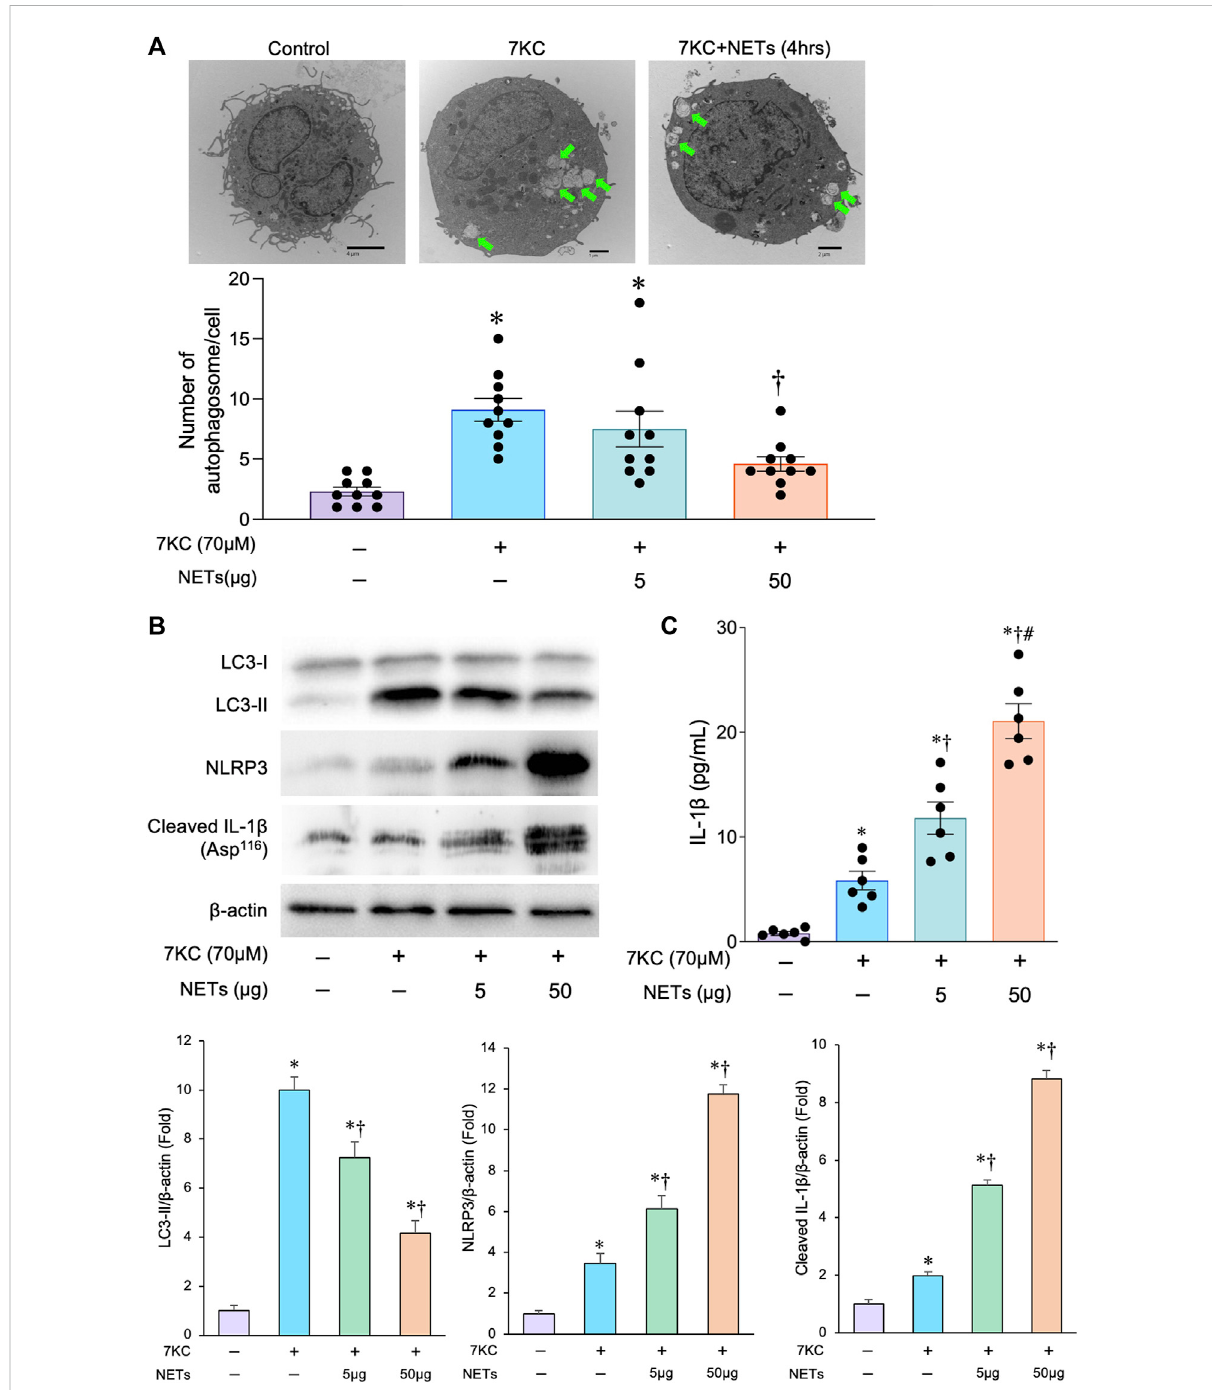
FIGURE 2 Effects of 7KC and NETs on macrophage autophagy in-vitro . (A) Upper panels: Representative transmission electron microscopic images of autophagosomes(arrows)inthemacrophagesdifferentiatedfromTHP-1cellswithandwithouttheadministrationof7KCandorNETs.Lowerpanel: Quantitativeanalysis ofthe number ofautophagosomes with and withouttheadministration of7KC and or NETs. * p < 0.05 vs. control group (Purple bar), † p < 0.05 vs. 7KC-treated group (Blue bar), n = 10 in each group. Data are expressed as dot plots and bars, with lines indicating the mean ± SEM. (B) Upper panel : Representative immunoblot images of LC3, NLRP3, cleaved IL-1 β , and β -actin. Lower panels: Densitometric analysis of immunoblots. * p < 0.05 vs. control group (Purple bar), † p < 0.05 vs. 7KC-treated group (Blue bar), n = 3 in each group. All data are expressed as mean ± SEM. (C) Macrophages differentiated from theTHP-1 cells with and without the administration of the 7KC and or NETs were analyzed for IL- 1 β secretion in the supernatants by the ELISA. * p < 0.05 vs. control group (Purple bar), † p < 0.05 vs. 7KC-treated group (Blue bar), # p < 0.05 vs. 7KC + NETs (5 μ g)-treated group (Green bar), n = 6 in each group. Data are expressed as dot plots and bars, with lines indicating the mean ±